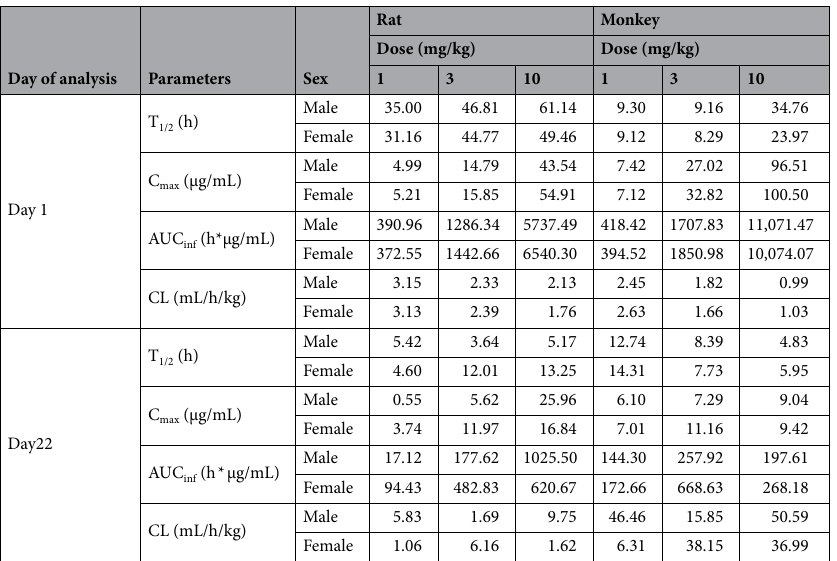
Table 2. Toxicokinetic parameters in Sprague Dawley rats and Cynomolgus monkeys administrated with GX-G3. Toxicokinetic parameters are based on mean values from three animals per group. T 1/2 = terminal half- life, C max = maximum serum concentration, AUC inf (h * μg/mL) = area under the curve (the concentration of GX-G3 in serum vs. time) from time zero to infinity, CL = total systemic clearance after